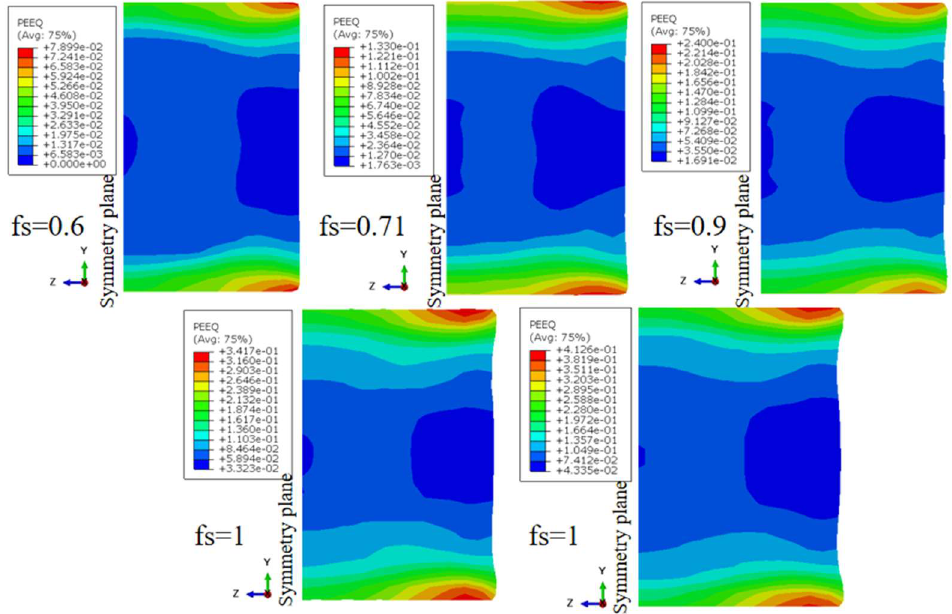
Figure 12. Equivalent plastic strain distribution on the transversal section of bloom under